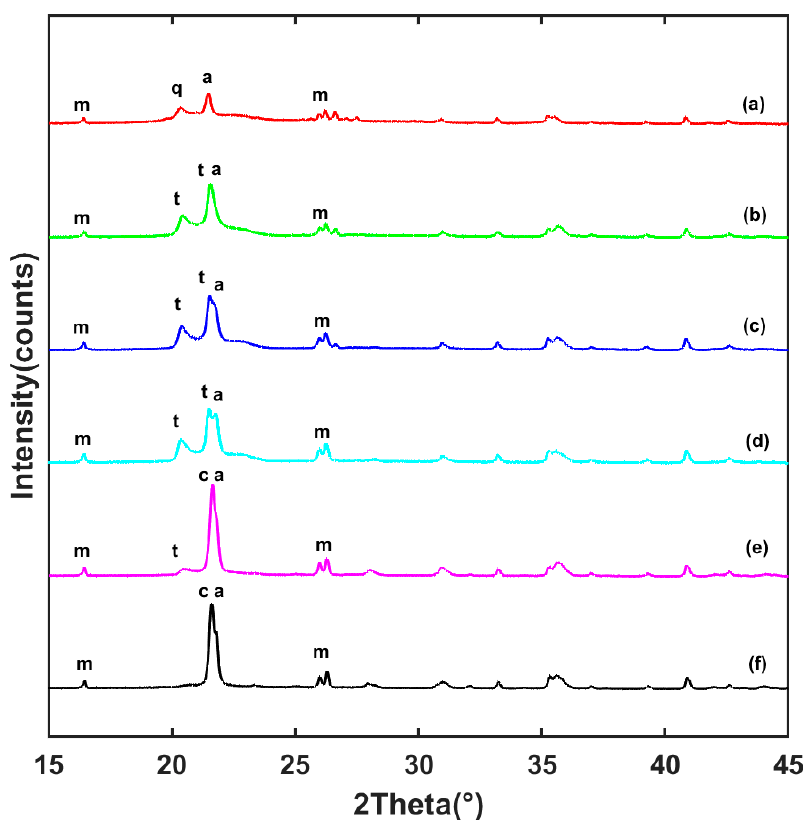
Figure 6. XRD patterns of the composites with 20% fiber addition as prepared or after various heat treatments for 1 h at: (a) room temperature, (b) 1150 ◦ C, (c) 1250 ◦ C, (d) 1350 ◦ C, (e) 1450 ◦ C, and (f) 1550 ◦ C. Peak symbols correspond to phases: m—mullite (PDF#15-0776), t—tridymite (PDF#18-1170), c—cristobalite (PDF#39-1425), a—aluminum phosphate (PDF#50-0303), q—quartz (PDF#46- 1045).